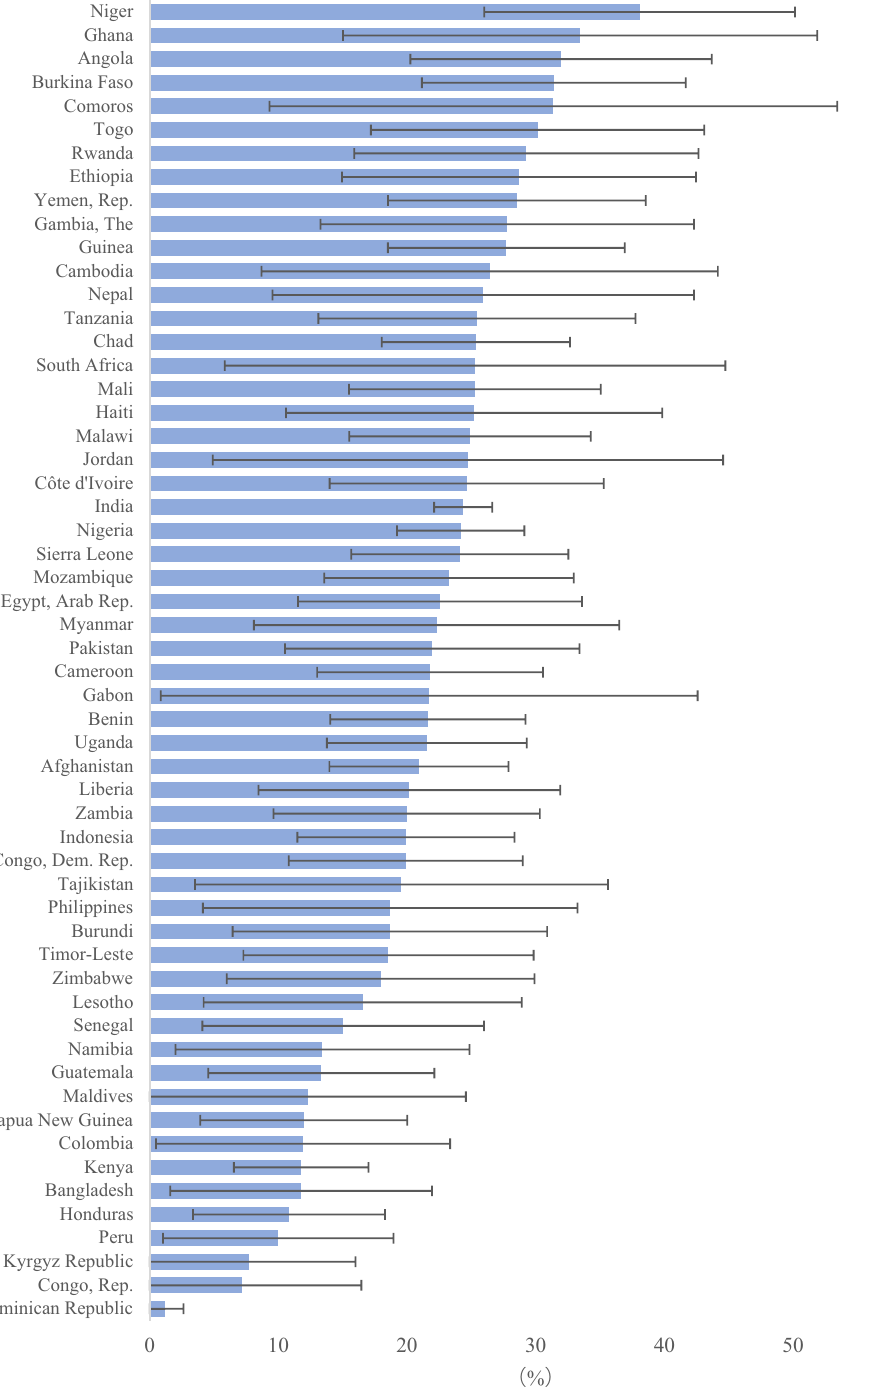
between history of neonatal deaths and subsequent neonatal mortality was stronger in the earlier neonatal periods (i.e. 0–7 completed days) in both the pooled and most country-level analyses. Moreover, the association was stronger among mothers with multiple previous neonatal deaths than those with one previous neonatal death. The large variation in the proportions of mothers with history of neonatal death suggests that with appropri- ate interventions, the prevalence of history of neonatal deaths in many countries can be potentially modified. For example, in Maldives, only 2% of the women had one or more previous neonatal deaths, and this is closely related to the country’s continuous efforts to tackle maternal and child health in the past two decades. Health